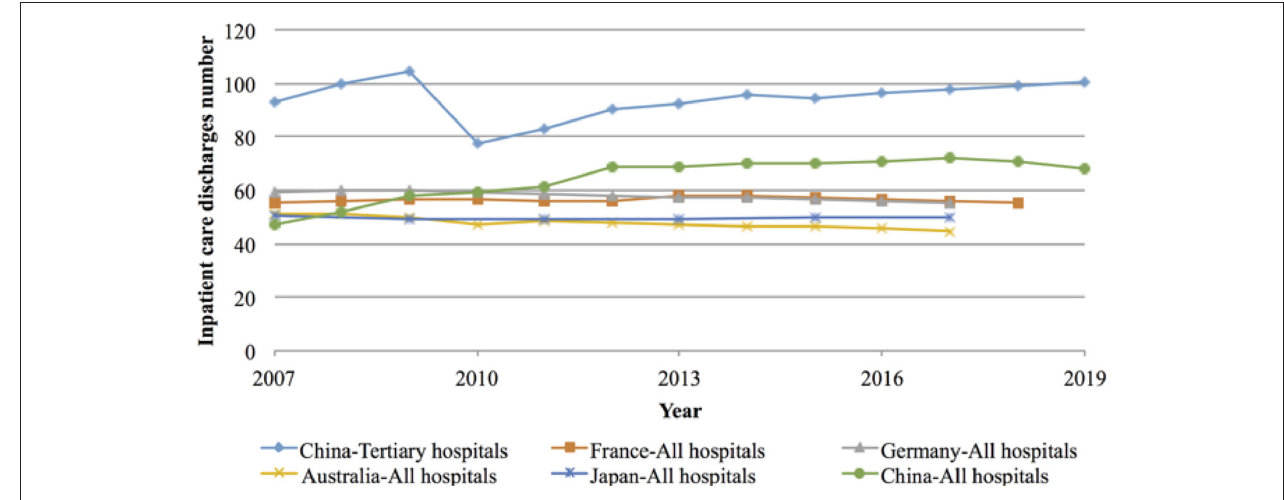
FIGURE 4 | Workload of inpatients per doctor in Europe (France and Germany), Asia (Japan and China), and Oceania (Australia) from 2007 to